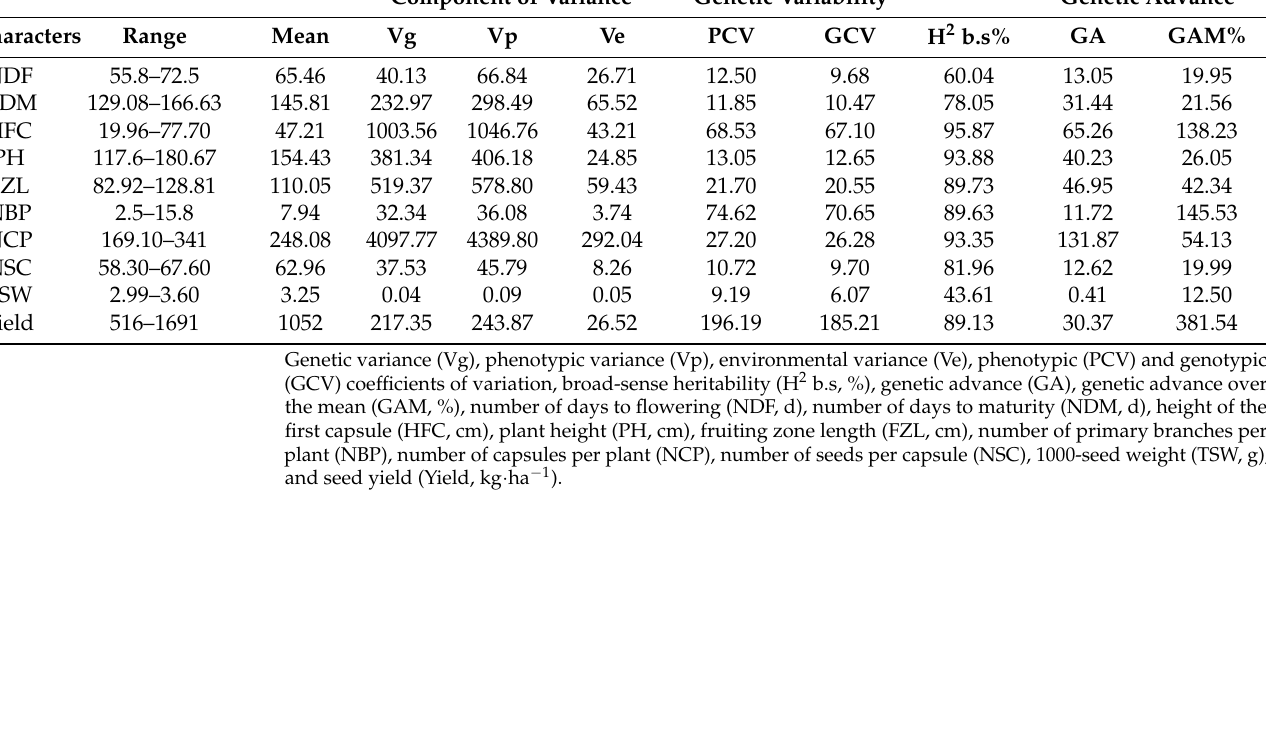
Table 5. Estimation of genetic parameters (genetic variance, phenotypic variance, heritability, and genetic advance) in 13 sesame genotypes for various phenological and agromorphological traits. Component of Variance Genetic Variability Genetic